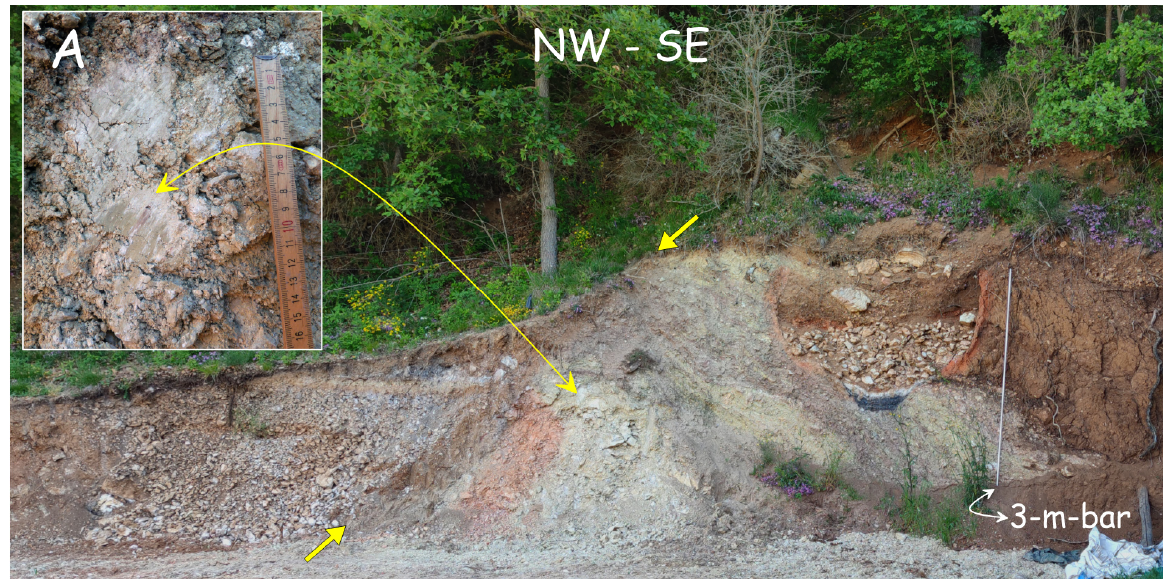
Figure 4. View looking northeast of the scraped fault-scarp hosting the limekiln (right-center). The kiln was set inside the Scaglia variegata formation (Eocene) and in brownish colluvia (Late Holocene). The yellow arrows indicate the low-angle intersection between the fault plane (N110°) and the undulated outcrop front. Panel ( A ) is a blow-up of the remnant of the striated slickenside in the Scaglia variegata marls.